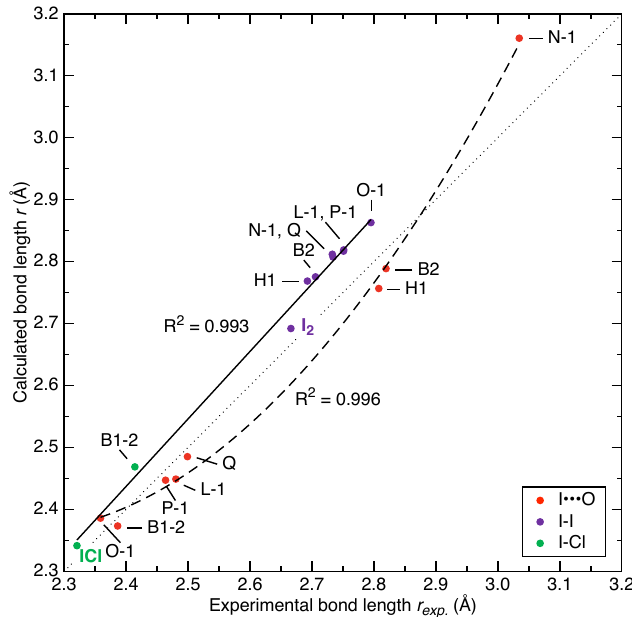
Figure 2. Comparison between calculated versus the experimental bond lengths in 8 crystal structures. The diagonal dotted line is y = x , i.e., reflecting 100% agreement between experimental and calculated values. Purple and green dots represent I-I and I-Cl covalent bonds, respectively. The diiodine (I 2 ) and iodine monochloride (ICl) molecules in gas phase are also included for comparison. The solid black line shows a linear fit ( R 2 = 0.993) for I-I and I-Cl covalent bonds altogether. The red dots representing I · · · O halogen bonds are best fitted with a quadratic curve ( R 2 = 0.996) shown as the dashed black